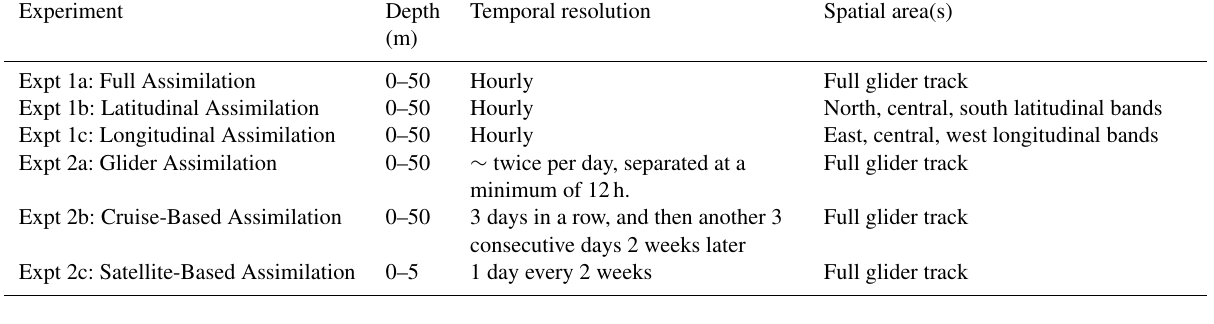
Table 2. Spatiotemporal resolution of glider-based observations of Chl and POC assimilated for each experiment.